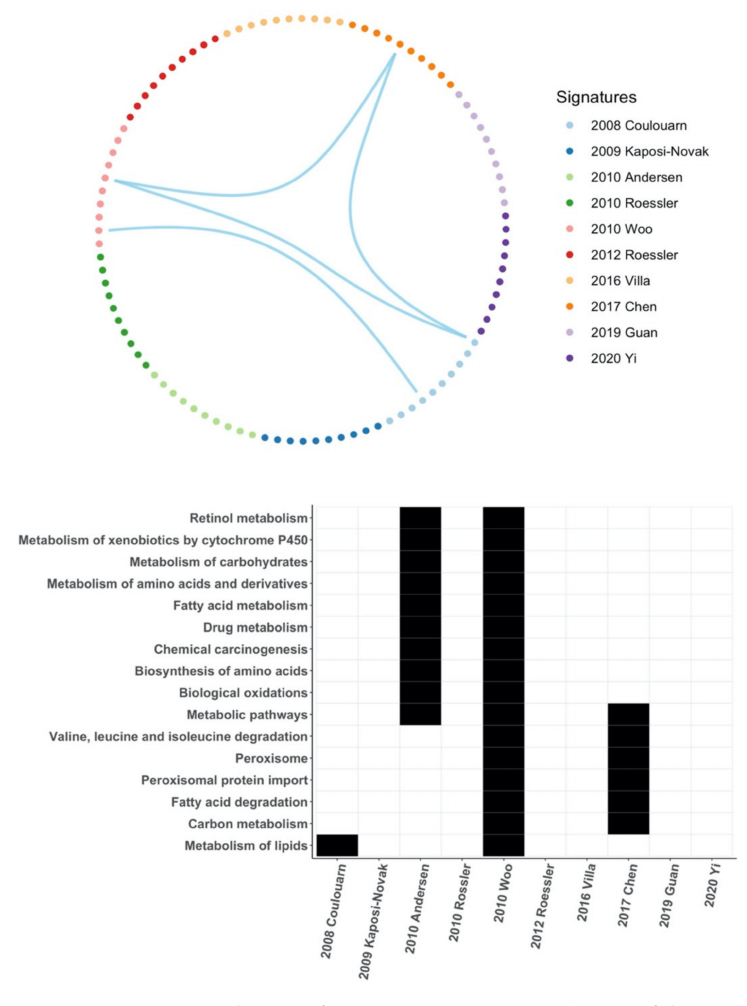
Figure 3. Common pathways of HCC gene signatures. Above : Of the top 10 pathways in each HCC gene signature based on the enrichment ratios, only two pathways overlap between three HCC gene signatures. Down : There are 16 overlapping pathways among the significant pathways screened by each HCC gene signature based on FDR < 0.05, but almost all of them overlapped between only two HCC gene signatures [10,11,16–23]. Table 6. Algorithms involved in the generation of HCC gene